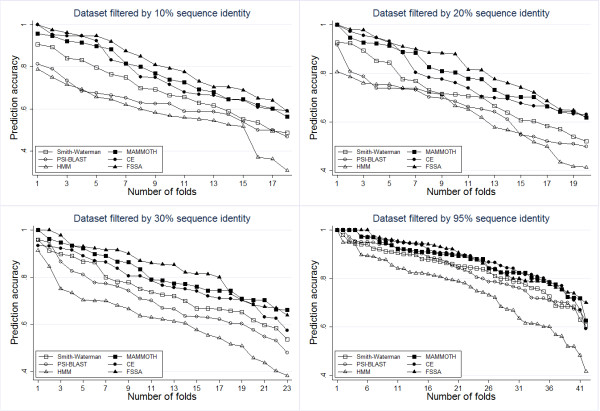
Relative performance of six function classification methods on data sets from the SCOP database that has been filtered by 10%, 20%, 30% and 95% pairwise sequence identity, respectively. We used all folds available (42 fold families in 95% sequence identity level), as opposed to our previous study, where only selected folds in the SCOP database was used (14 fold families in 95% sequence identity level). For each function classification method, the number of SCOP folds is plotted against the minimum prediction accuracy achieved by that method. The FSSA algorithm has the overall best performance in function classification when sequence identity is less than 30%.